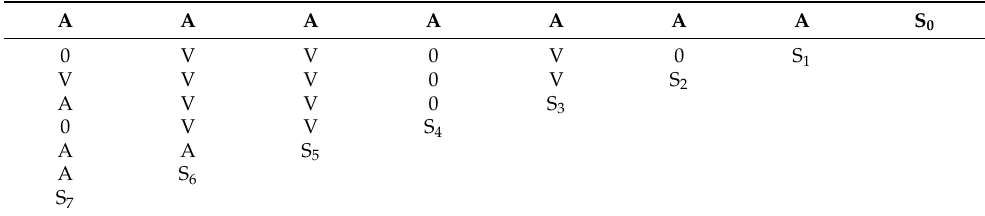
Table 3. Logical relationship of influencing